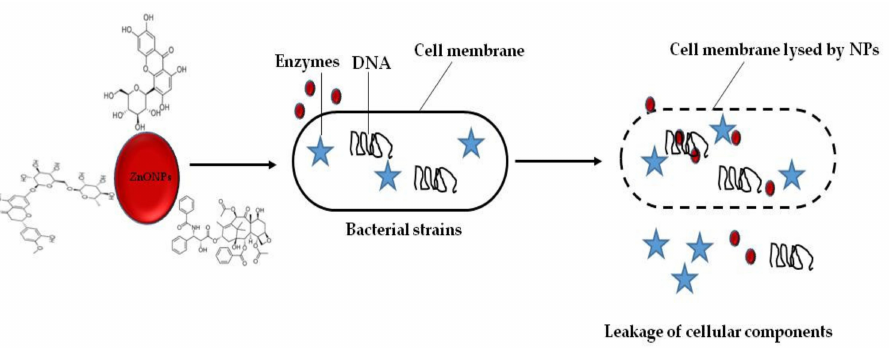
Figure 4. Mechanism of ZnO NPs against bacterial strains. ZnO NPs exhibited remarkable inhibition of cell growth and cell death in bacterial strains following the direct interaction between the ZnO NPs and the bacterial cell surface. Adapted from